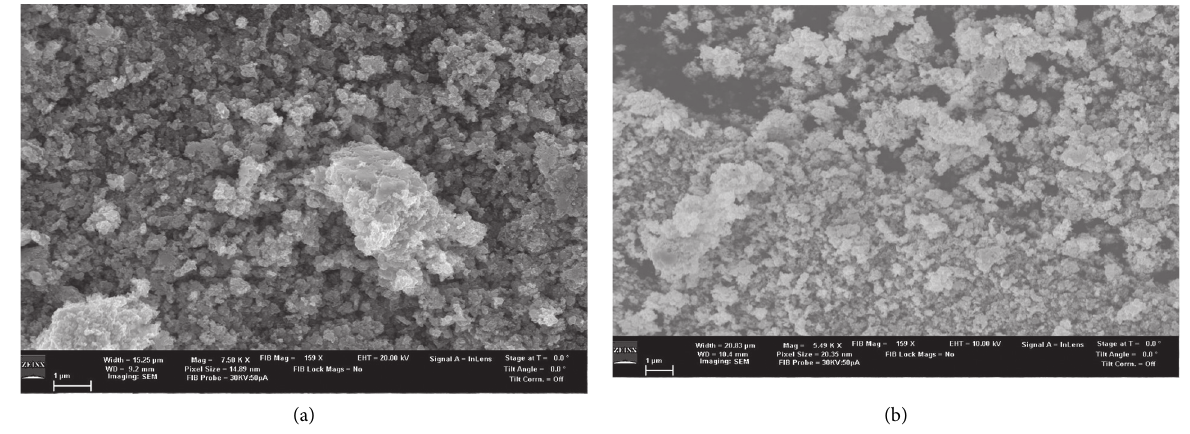
Figure 5: (a) SEM of CL-AgNPs. (b) SEM of CP-AgNPs.